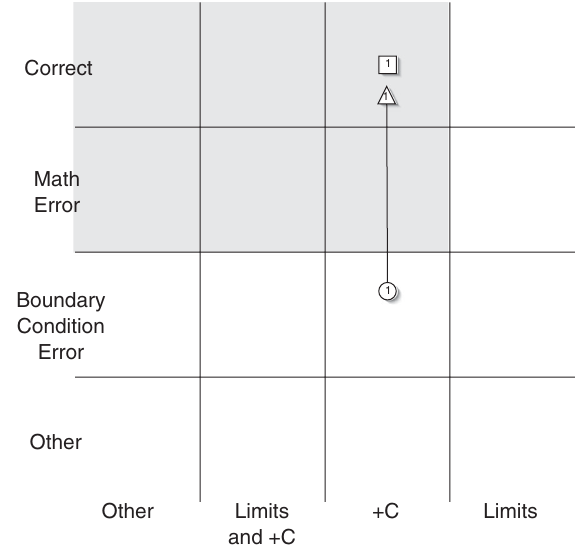
FIG. 12. Void pattern. Nearly no answers are found in an extended region of the consistency plot.